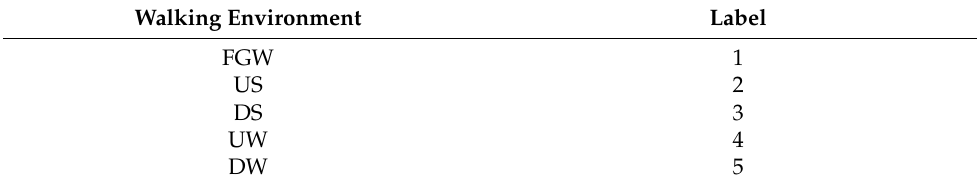
Table 1. Labeling table. The walking environments are labelled in a sequence.